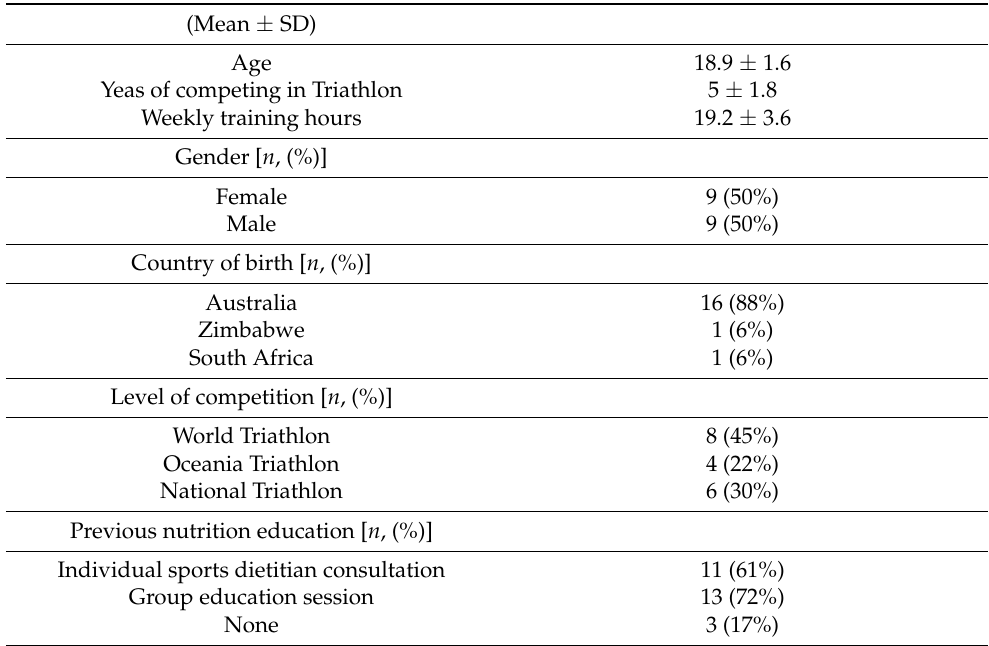
Table 1. Demographic characteristic of elite junior triathletes undertaking the 8-week nutrition education program ( n =